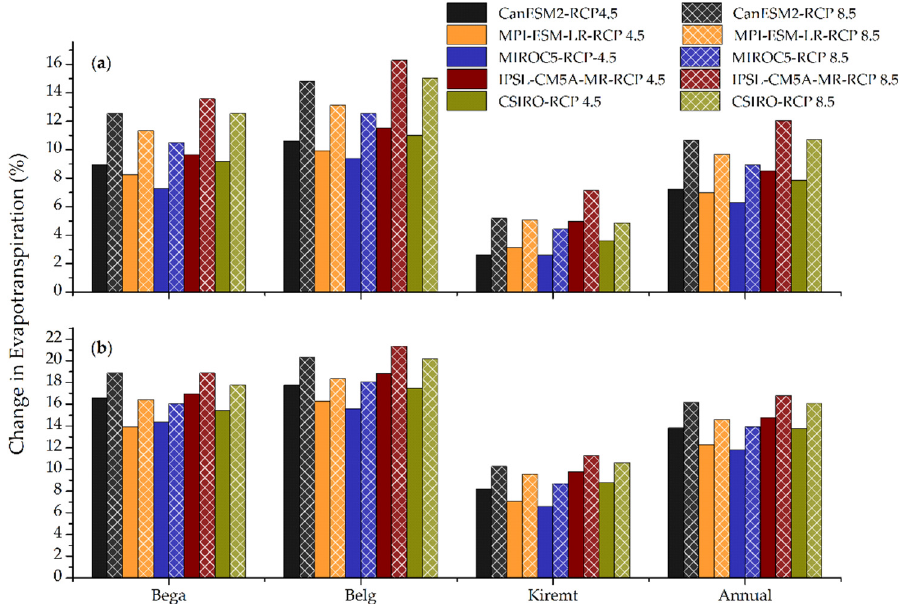
Figure 15. Percentage changes of annual and seasonal evapotranspiration with reference to the baseline in the: (a ) near future period from 2021–2050; and ( b ) far future period from 2071–2100.